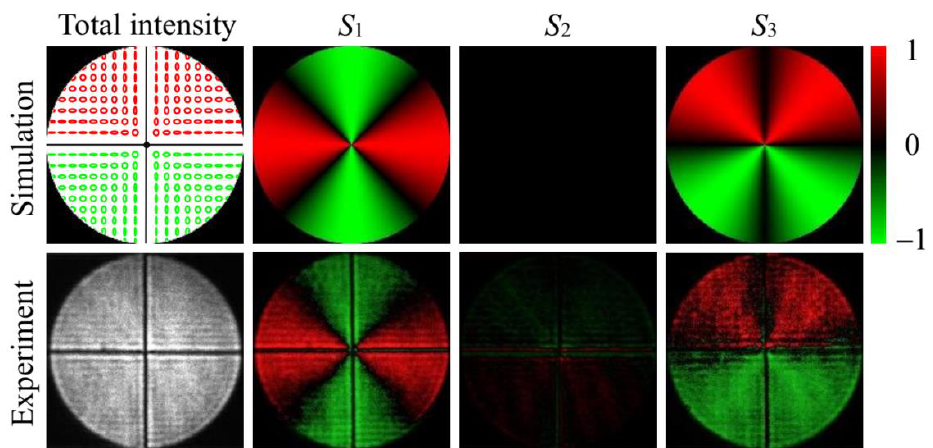
Figure 1. Simulated and measured SM-HP-VOF when ( N , m ) = (2, 1) . The first and second rows show the simulated and experimental results of the SM-HP-VOF. The first column shows the polarization state and the experimental total intensity pattern. The red and green polarizations represent right- and left-handed elliptic (circular) polarizations, respectively. Stokes parameters S 1 , S 2 , and S 3 are given in the second to fourth columns, respectively.